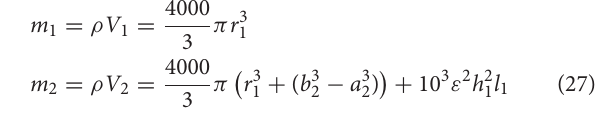
1m) of spherical = k ( m − 1 ), projection of the = | |